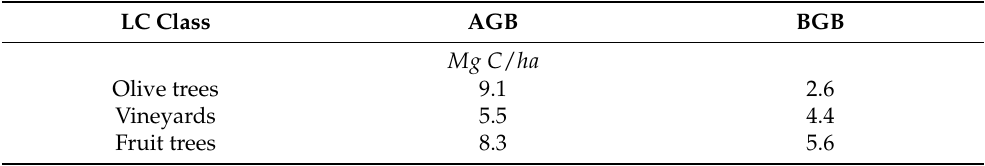
Table 9. Carbon stock values for some agricultural classes.